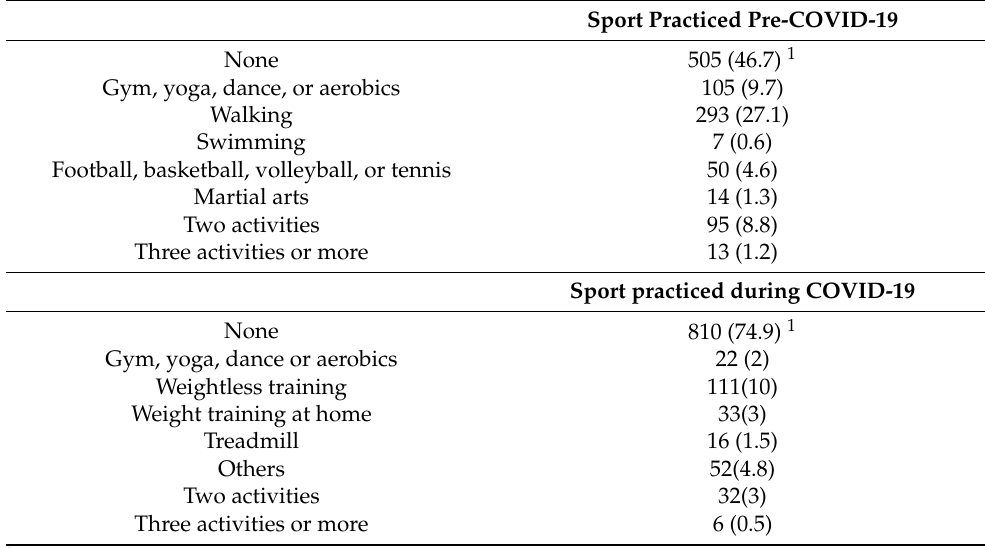
Table 5. Physical activities before and during COVID-19